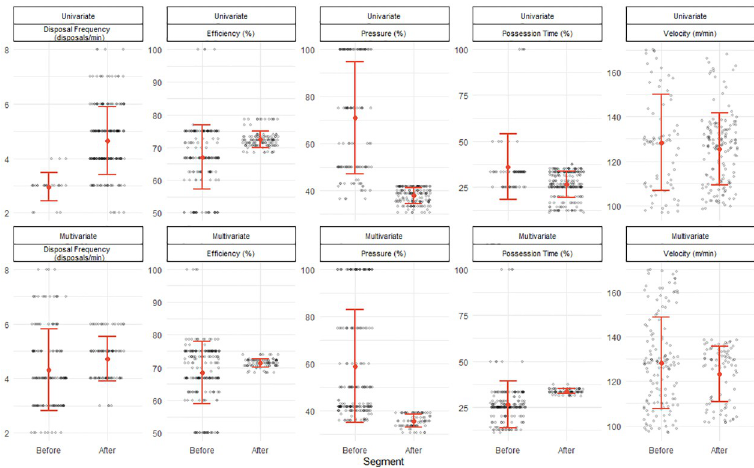
Fig 4. Summary statistics for segmented features according to a univariate and multivariate change point analysis of a single training activity. The orange point and error bars display the mean and one standard deviation of the segment, respectively. The black points each represent one second of the underlying segmented